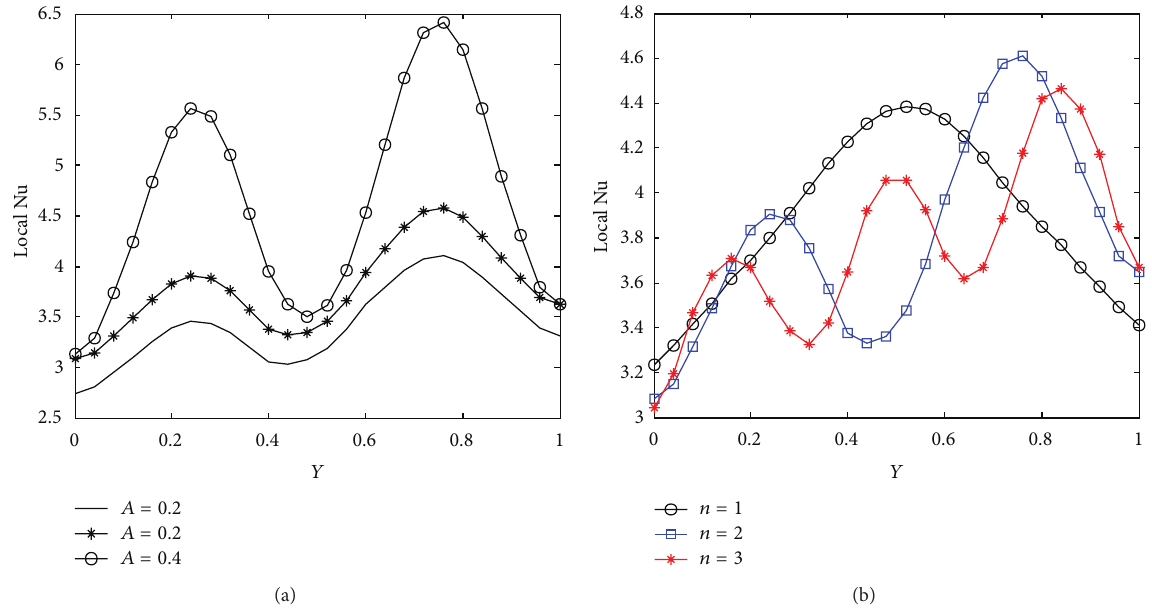
Figure 14: Variation of local nusselt number with Ra = 10 5 , Pr = 0.7 , ℎ𝑥 = 0.55 , and ℎ𝑦 = 0.55 at cold wavy surface (a) with wavy surface amplitude (𝐴) and (b) with number of undulations (𝑛) .